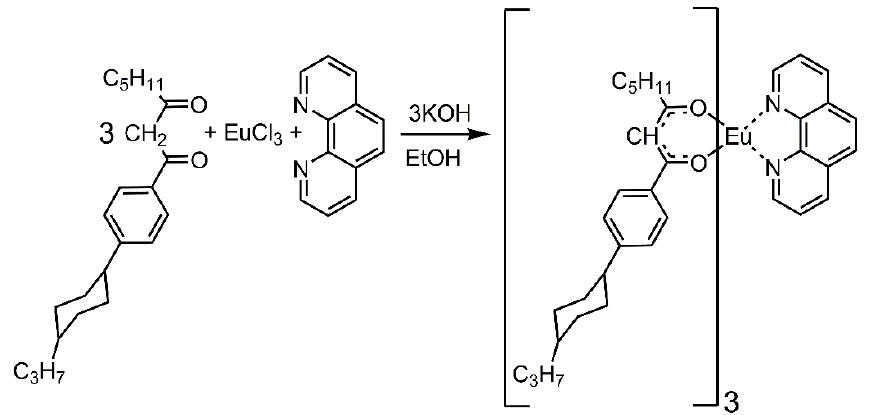
Figure 1. Synthesis of tris( β -diketonate) Eu(III) complexes with 1,10-phenanthroline.